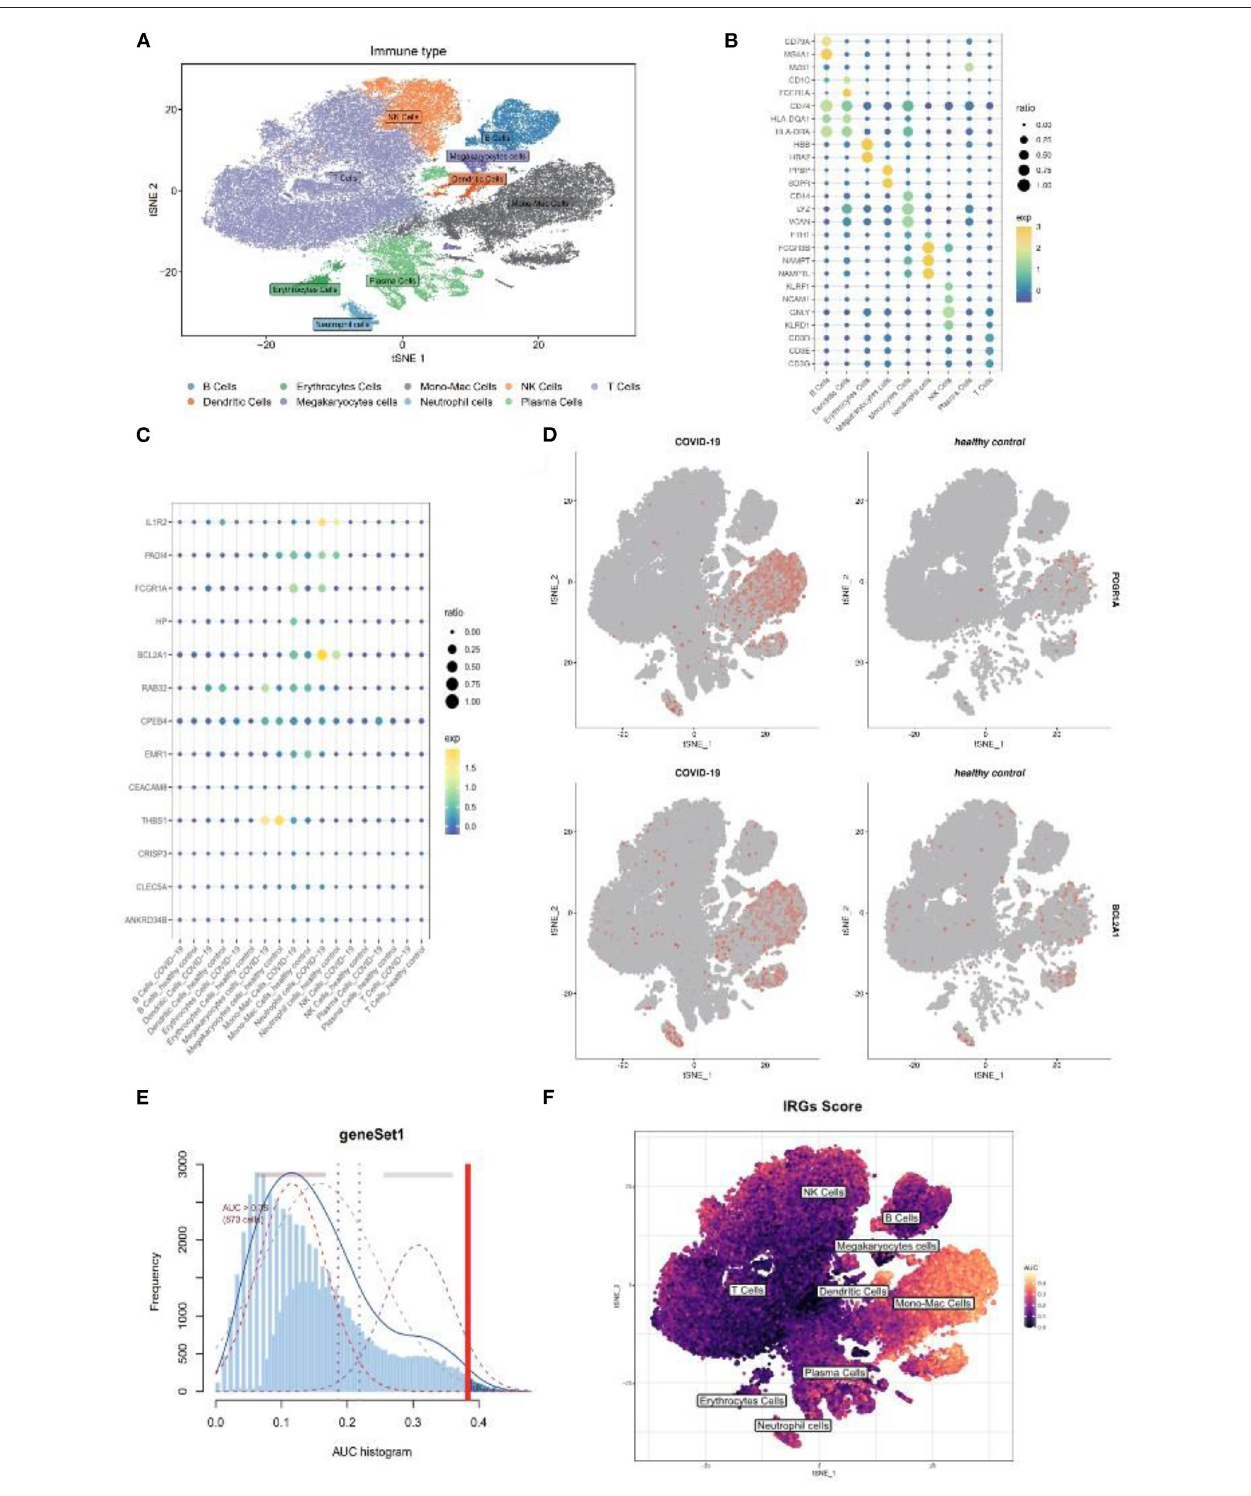
FIGURE 7 | Further validation of above results in a COVID-19 scRNA dataset. (A) t-SNE plot visualization of nine clusters. (B) The respective marker genes of nine clusters in a dot plot. (C) Dot plot shows the expression level of target genes in the COVID-19 and healthy samples. (D) Expression of FCGR1A and BCL2A1 using a t-SNE plot. (E) A threshold of 0.38 for immunity-related genes (IRGs) score calculation was selected. (F) t-SNE plot of IRGs score in nine clusters. t-SNE, T-distributed stochastic neighbor embedding; COVID-19, coronavirus of 2019; scRNA, single-cell RNA.